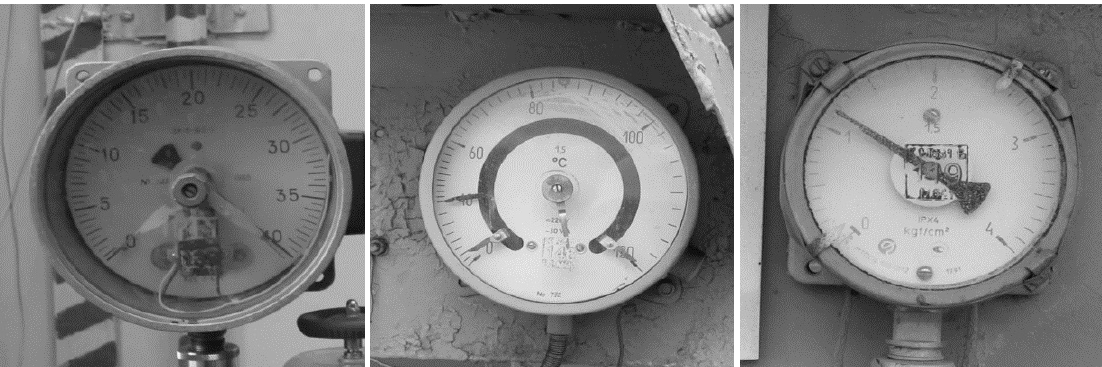
Figure 1. Examples of analog dial